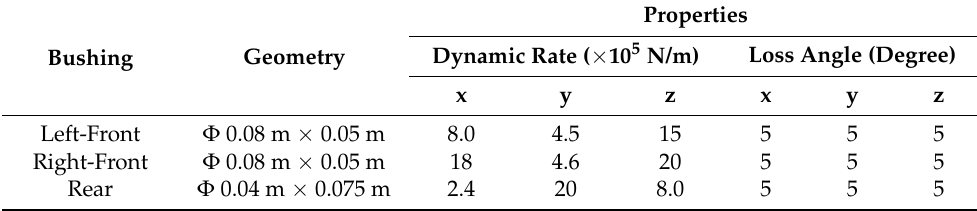
Table 1. Properties of the bushings.